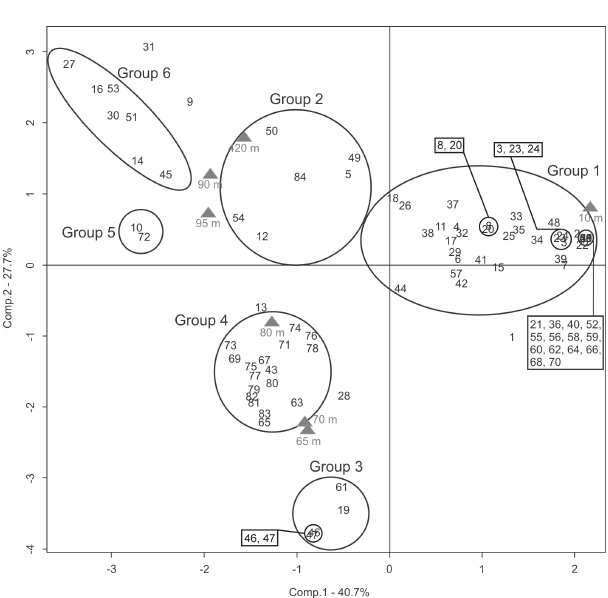
Figure 3. PCA of the relative abundances of compounds in differ- ent water depths. Group 1: surface maximum; a subgroup of com- pounds exclusively occurring at the surface are listed in the box. Group 2: surface and lower suboxic zone maxima. Group 3: cold winter water layer maximum. Group 4: oxic-zone high concentra- tions. Group 5: suboxic zone maximum. Group 6: absent in oxic zone, bottom layer maximum. Compound names are given in Ta- ble